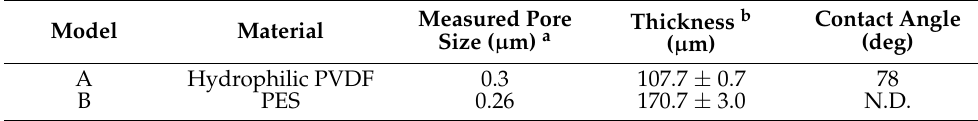
Table 2. Characteristics of commercial sterile